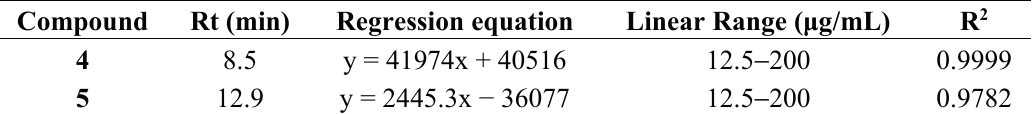
Table 2. Regression equations and retention times of compounds 4 and 5 determined for the HPLC assay.